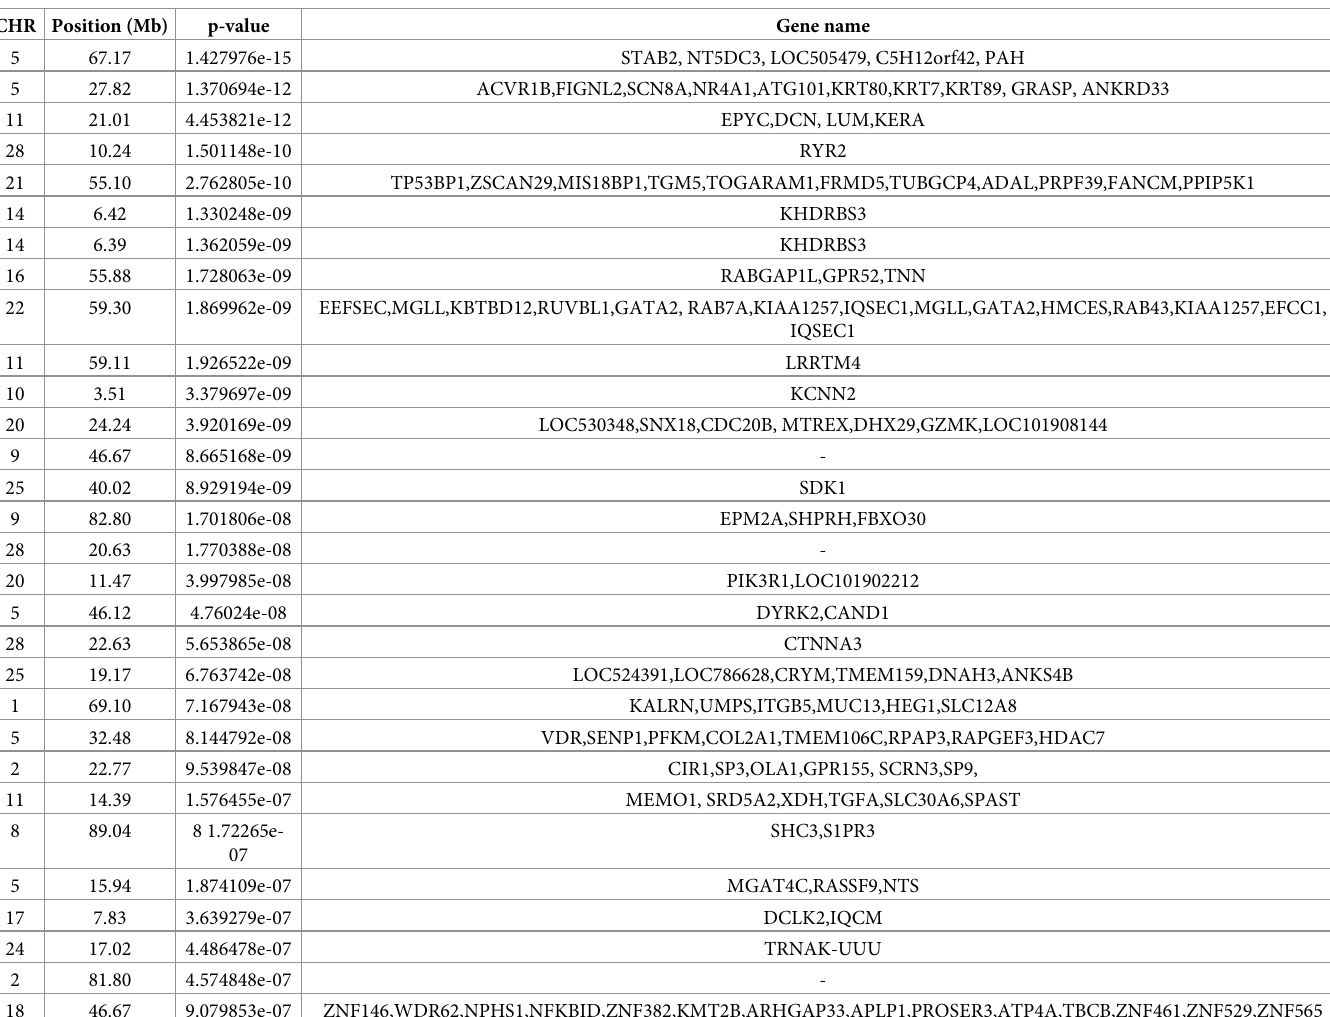
Table 4. Significant SNP positions and genes detected for ear position.